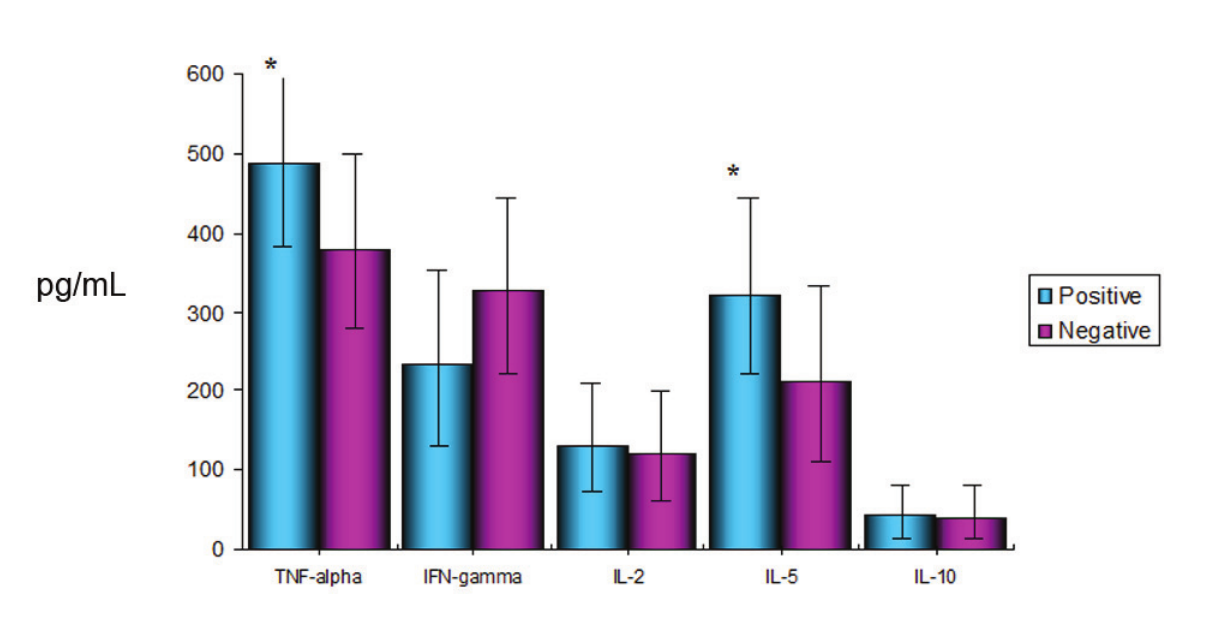
Figure 2. Mean TNF-α, INF-γ, IL-2, IL-5, and IL-10 serum levels according to intestinal parasitic infections in HIV/AIDS individuals treated at the Specialized Outpatient Service and Day Hospital Professor Emeritus Domingos Alves Meira, UNESP, 2007-2008. The p values were obtained by the Kruskal-Wallis test to compare infected and non-infected individuals for each